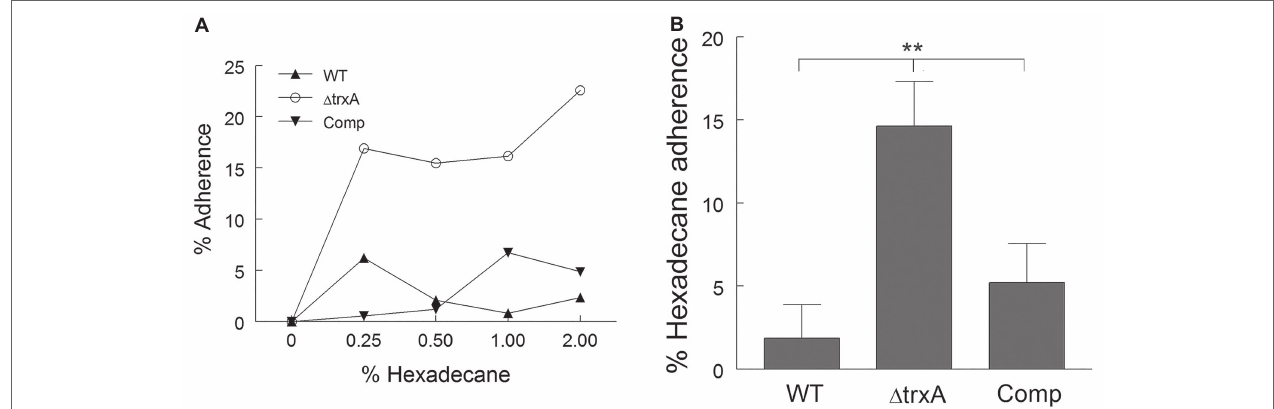
FIGURE 1 | Loss of thioredoxin increases cell surface hydrophobicity. (A) Cell surface hydrophobicity of wild type (WT), Δ trxA and complement (Comp) strains was measured using Microbial Adhesion to Hydrocarbon, with various concentrations of n-hexadecane. (B) Adherence to n-hexadecane at 1:100 concentration of n-hexadecane to bacterial suspension. Statistical differences were determined by one-way ANOVA with Holm-Sidak correction for multiple comparisons (** p <